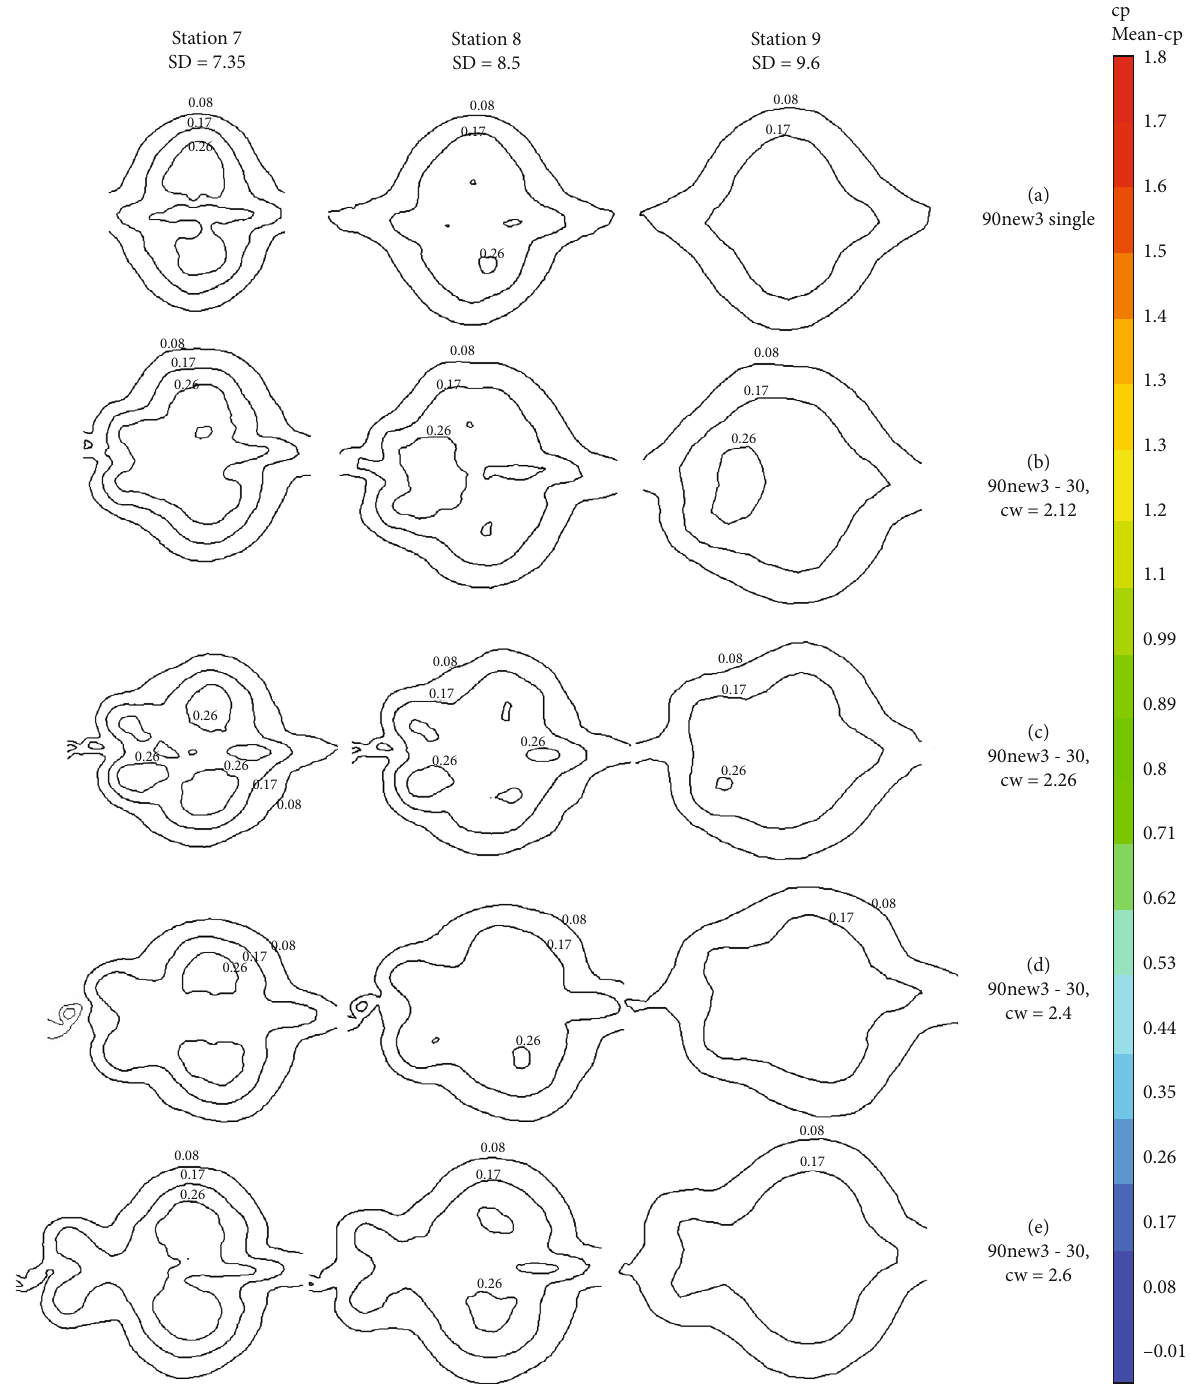
Figure 15: Loss distributions in the form of time-averaged cp isolines at the stations located in fully developed wake obtained from present numerical simulations. (a) 90new3 single and 90new3-30 spacing equal to (b) CW = 2 : 12 , (c) CW = 2 : 26 , (d) CW = 2 : 4 , and (e) CW = 2 : 6